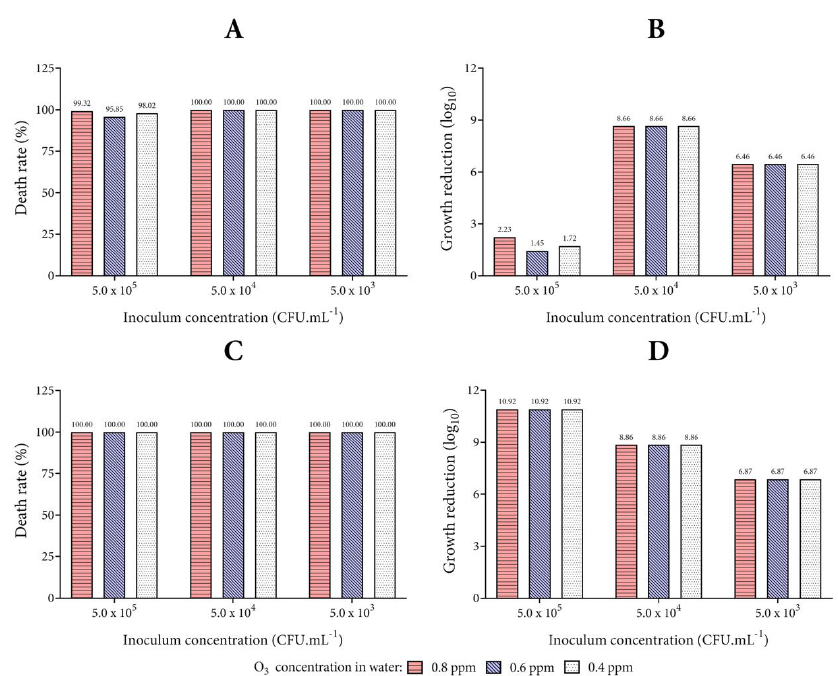
Figure 5. Action of ozonized water on Gram-negative bacteria. Analysis of the percentage of death and growth reduction in Log 10 for the microorganisms E. coli ( A , B ) and P. aeruginosa ( C , D ). The concentrations of 0.8, 0.6, and 0.4 ppm of O 3 dissolved in tap water were tested, and the number of colonies on each agar plate was calculated after incubation (1.0 mL of inoculum and 4.0 mL of ozonized water at 20 °C for 1 min).